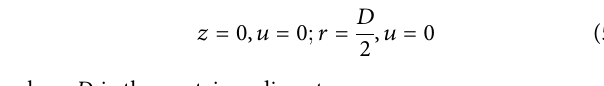
Frontiers in Bioengineering and Biotechnology |